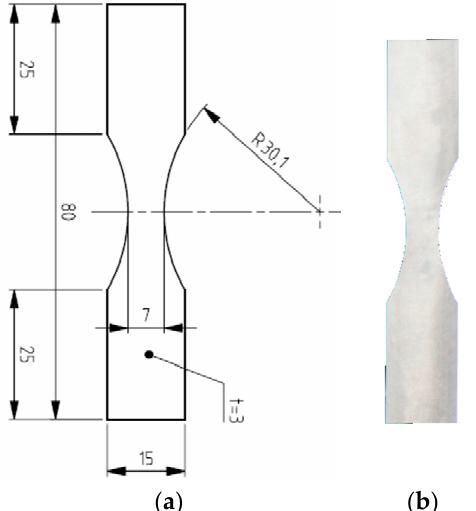
Figure 2. ( a ) Dimensional drawing of the specimen after post-machining; ( b ) picture of the LENS specimen after machining.